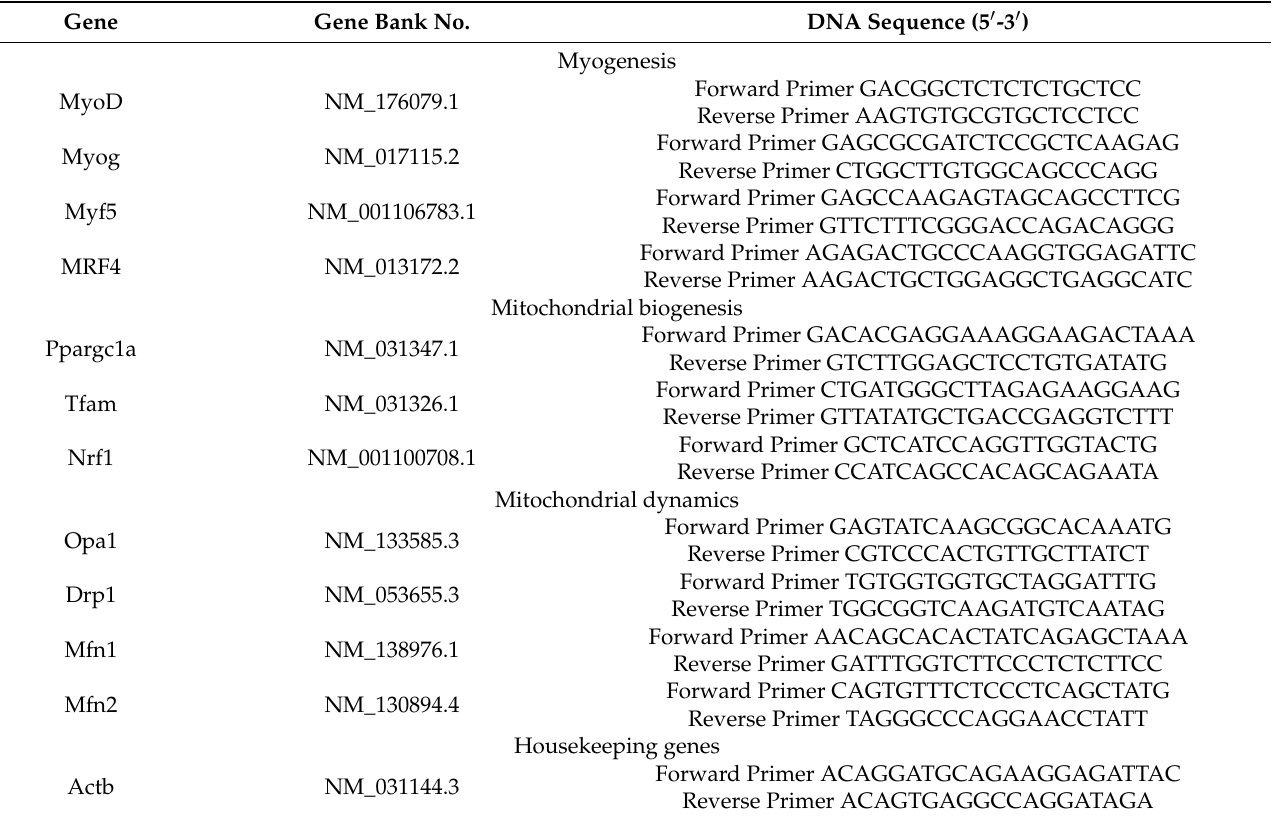
Table 1. Summary of qPCR oligonucleotide primers used in measuring mRNA expression of genes related to myogenesis, mitochondrial biogenesis and dynamics. Gene Gene Bank No. DNA Sequence (5 (cid:48) -3 (cid:48)